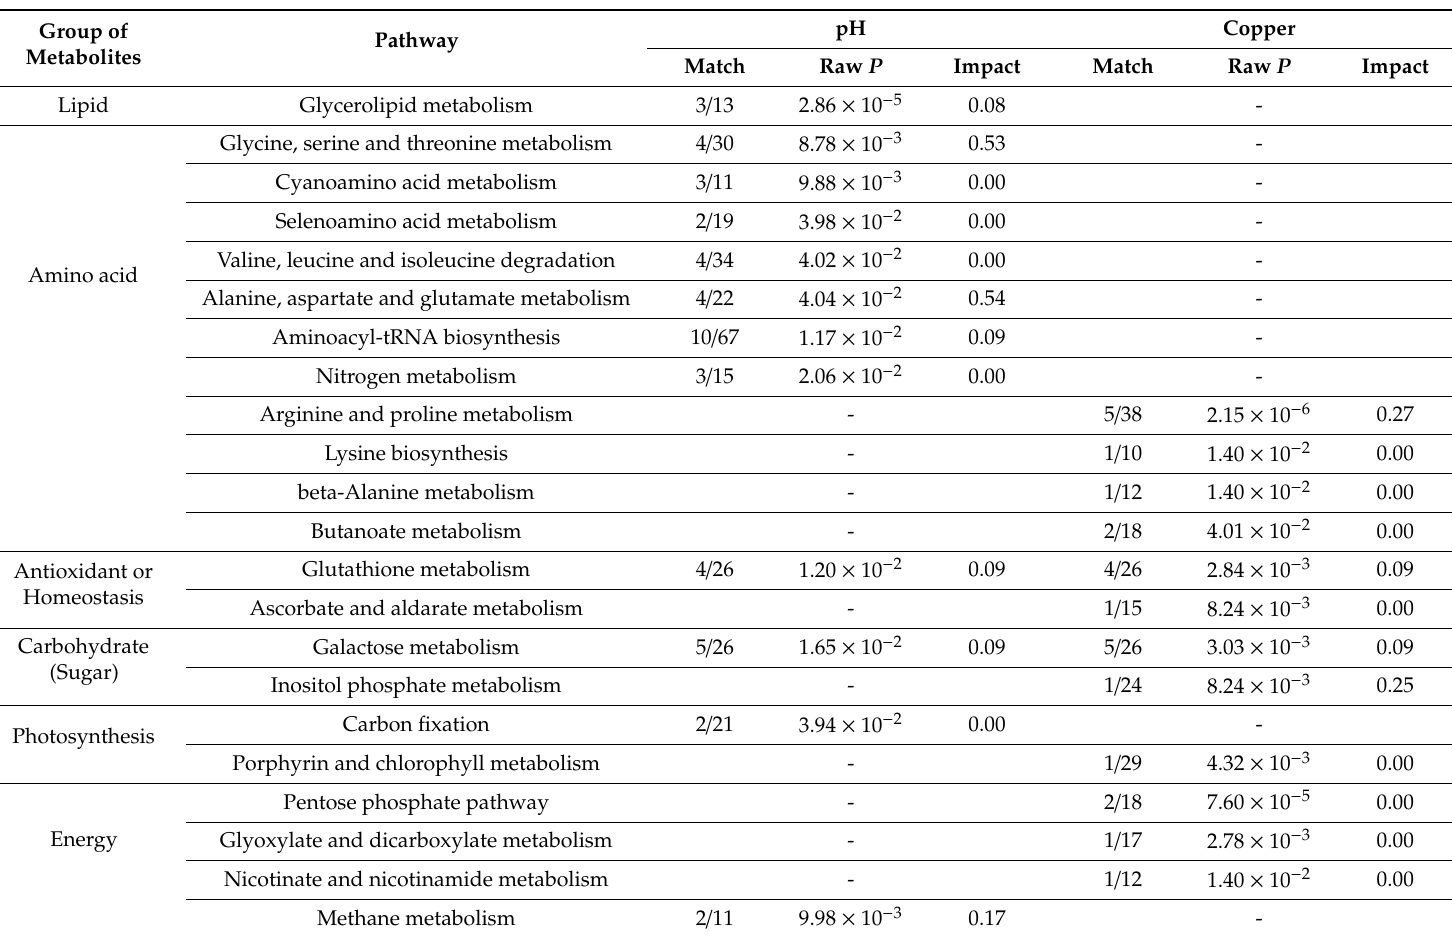
Table 2. Pathway analysis of the putatively identified metabolites by GC-MS in MetaboAnalyst open source 237 software (v4, pathway analysis tool) using the Arabidopsis thaliana metabolic 238 pathway library. The pathway analysis shows the e ff ect of copper and pH on Desmodesmus sp. AARLG074 based on the number of metabolites matched in a metabolic pathway (Match), the statistical significance of the number of metabolites and their treatment response in that pathway (Raw P) and the importance of that pathway change in the network (Impact)